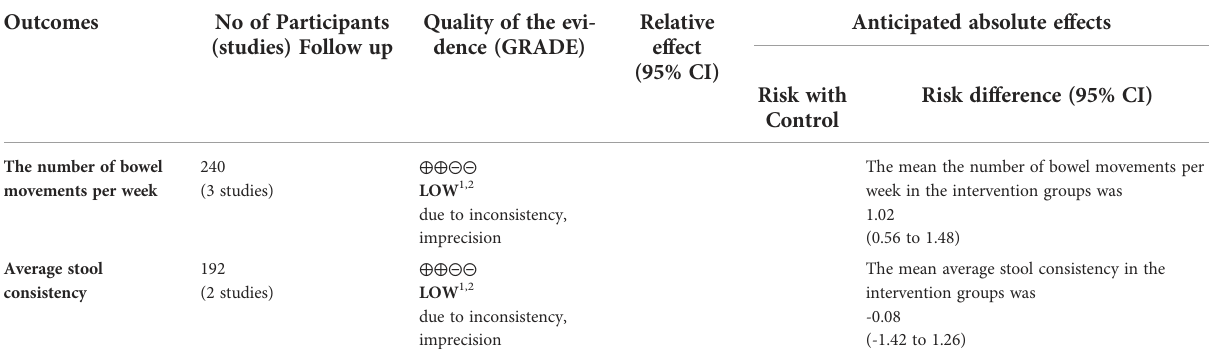
TABLE 3 The result of the